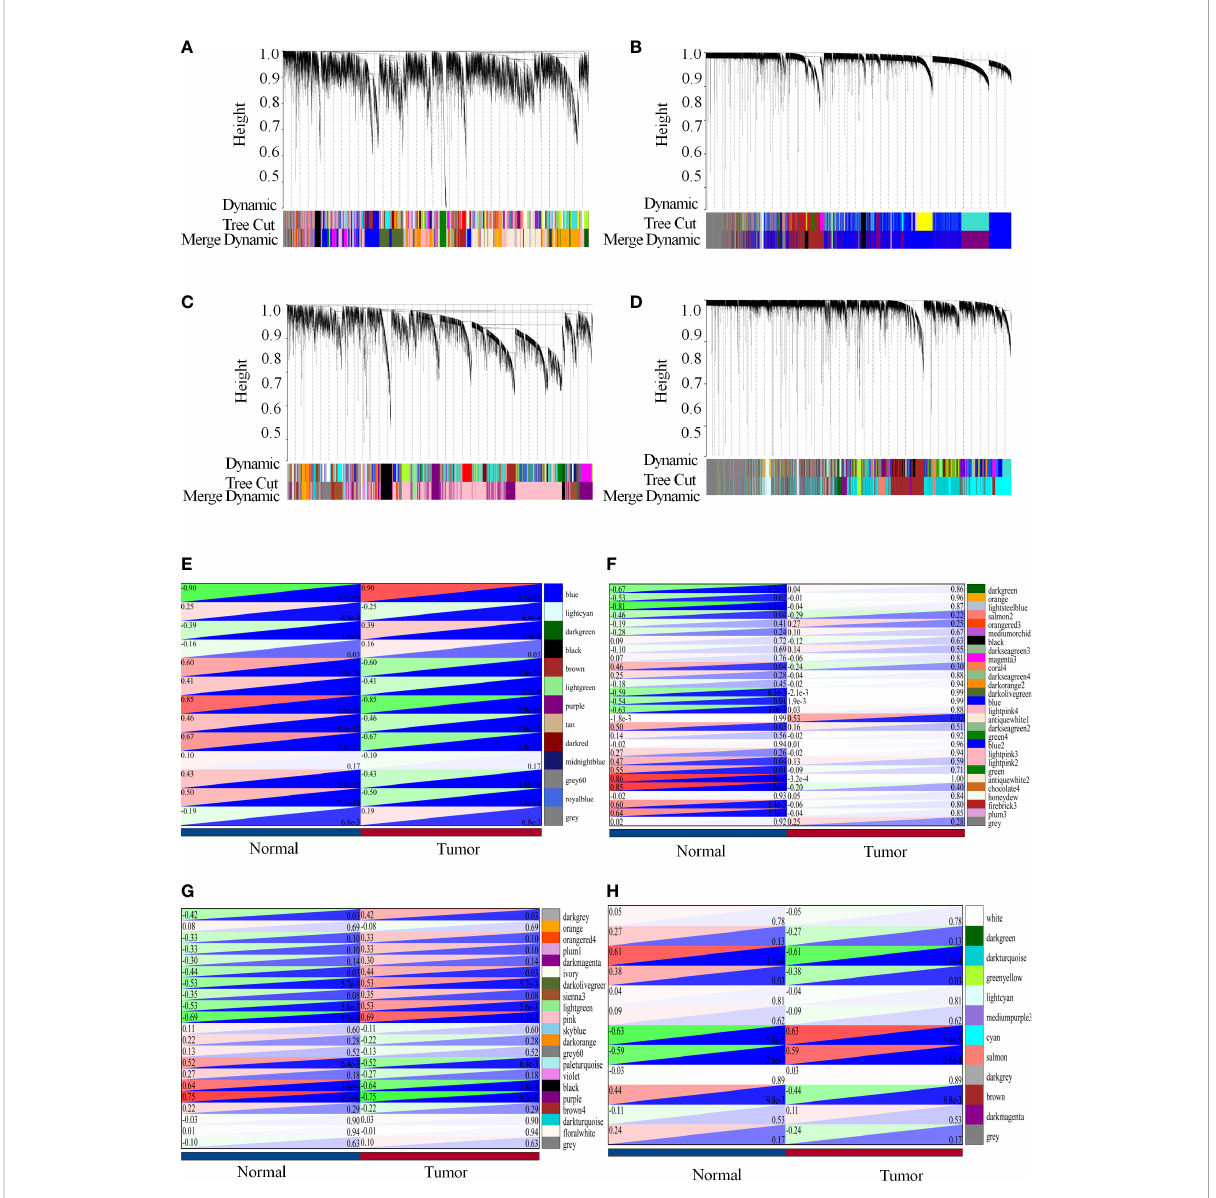
FIGURE 4 Modular genes constructed by WGCNA possibly play an essential role in colon carcinogenesis. (A-H) WGCNA analysis of each data set. (A, E) WGCNA analysis of the GSE41328 dataset. (A) Co-expression modules of the GSE41328 dataset; (E) Relationship between selected modules and clinical features. (B, F) WGCNA analysis of the GSE44076 dataset. (B) Co-expression modules of the GSE44076 dataset; (F) Relationship between selected modules and clinical features. (C, G) WGCNA analysis of the GSE110223 dataset. (C) Co-expression modules of the GSE110223 dataset; (G) Relationship of selected modules to clinical features. (D, H) WGCNA analysis of the GSE110225 dataset. (D) Co- expression modules of the GSE110225 dataset, and heat maps based on adjacency relationships. (H) Relationship of selected modules with clinical